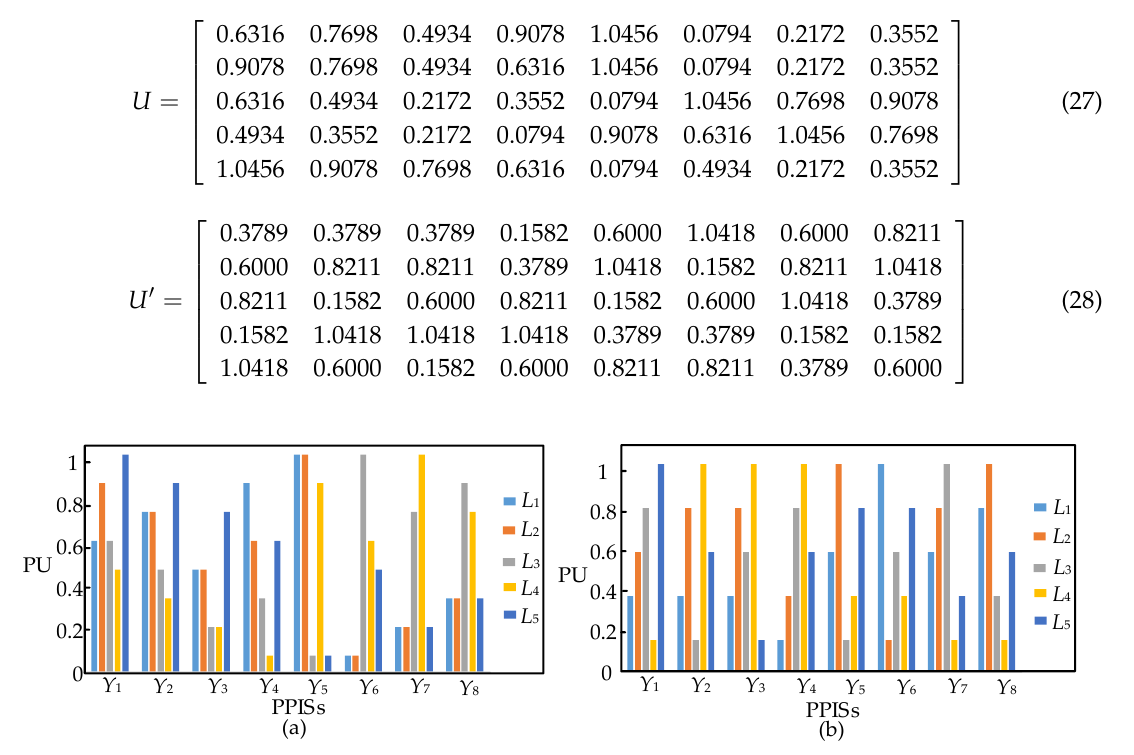
Figure 10. SCs’ and NERC’s PU, ( a ) is SCs’ PU towards different premium power investment schemes (PPISs); ( b ) is NERC’s PU towards different SCs, as for different PPISs.